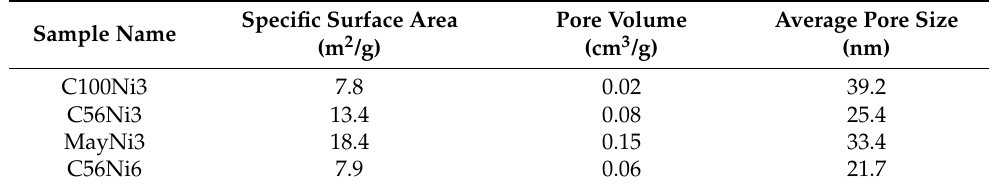
Table 6. Specific surface area, pore volume and average pore size of bi-functional